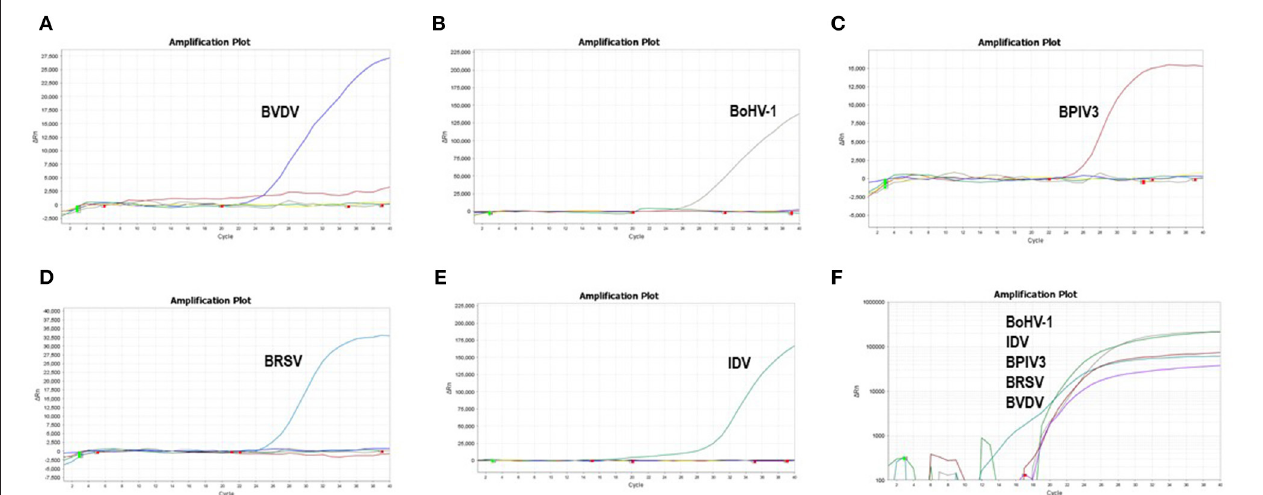
FIGURE 3 | Specificity of the multiplex real-time PCR assay: The data were represented with amplification curves (X-axis: Cycle, Y-axis: 1 Rn) (A–E) Amplification curves represent samples positive for BVDV, BoHV-1, BPIV3, BRSV and IDV detected by the multiplex real-time PCR assay. (F) Co-infection simulation experiments with nucleic acids of five pathogens extracted from cell culture The viruses can be detected by our multiplex real-time